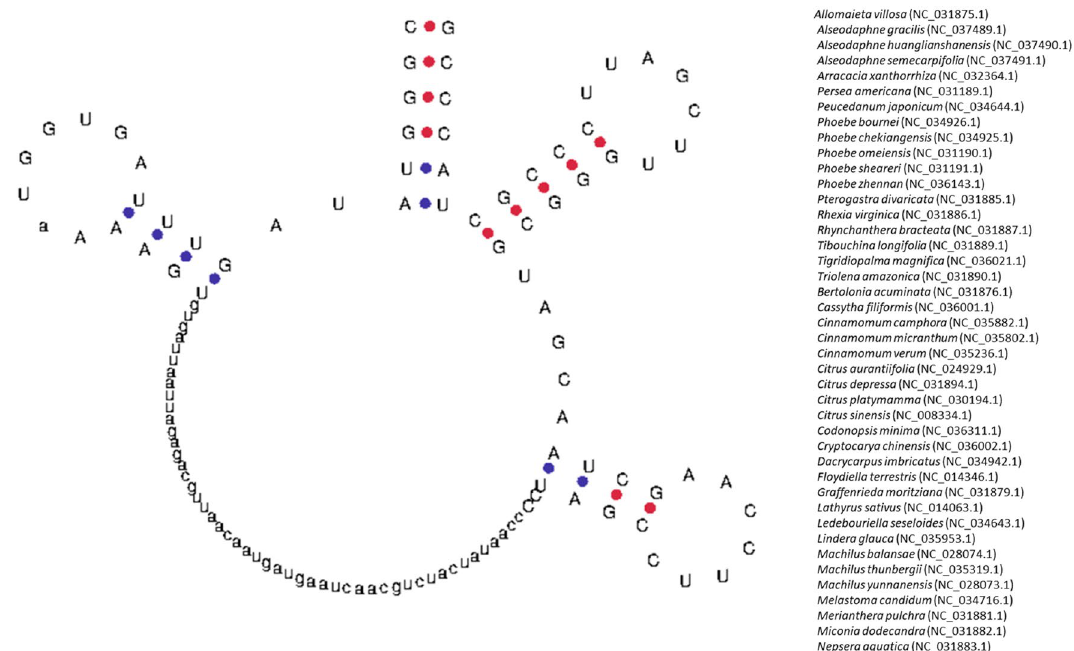
Figure 4. Putative novel tRNA of chloroplast tRNA. The tRNA contains a long nucleotide sequence in between the D-arm and anticodon arm. At least 42 chloroplast genomes are found to encode a similar tRNA structure in it. The structure was predicted using the tRNAscan-SE 2.0